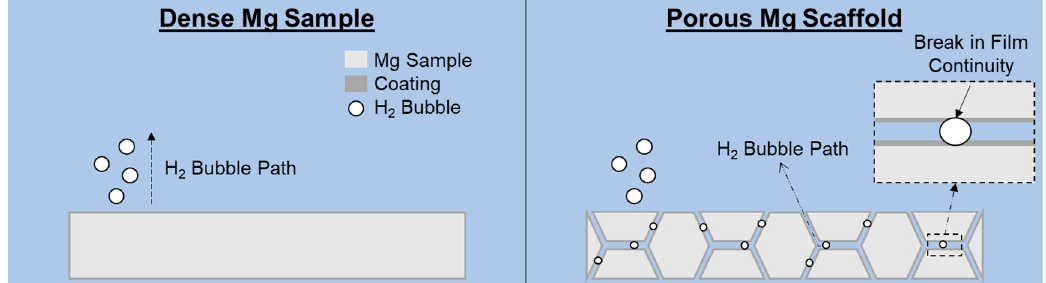
Figure 10. Schematic of the phosphate conversion coating forming process of both dense Mg sample and porous Mg scaffold. As the hydrogen gas that evolves within the pore channels is unable to escape freely, its accumulation leads to a break in film continuity during the film formation process.